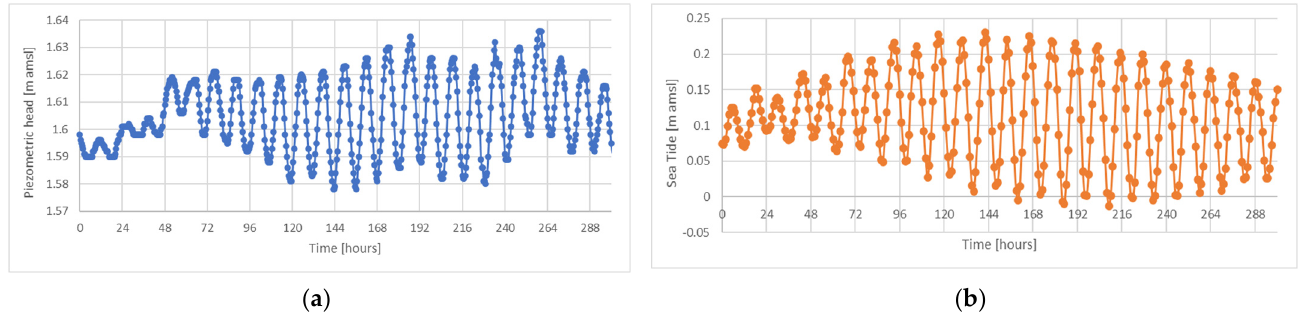
Figure 5. ( a ) observed groundwater level fluctuations in Madliena monitoring borehole; ( b ) observed sea tides in Portomaso sea gauge.